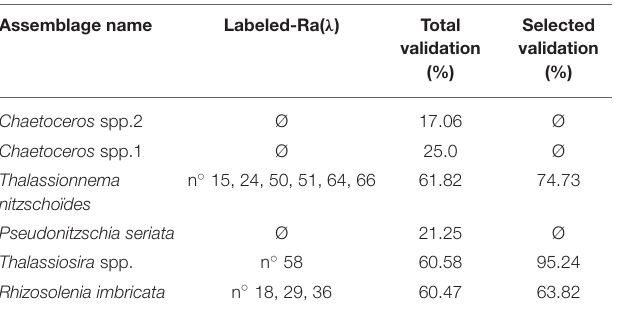
TABLE 3 | This table represents the validation scores in two ways: (i) the total validation scores, which take into account all labeled-Ra( λ ) in each 1,200 repetition of the calibration/validation procedure (average of all validation scores displayed in Figure 6 ) and (ii) the selected validation score according to the rate of labeling (see Figure 4 and section 2.4.4), which take into account only the robustly labeled-Ra( λ ) (average of validation scores with a gray background in Figure 6